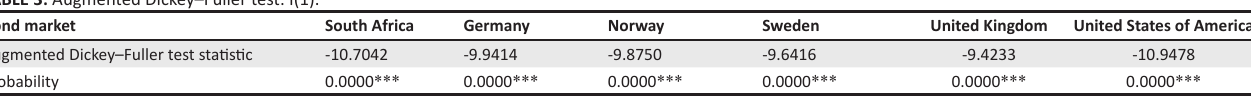
TABLE 3: Augmented Dickey–Fuller test: I(1). Bond market